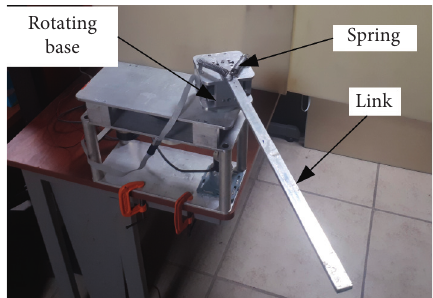
Figure 3: Rotatory flexible link